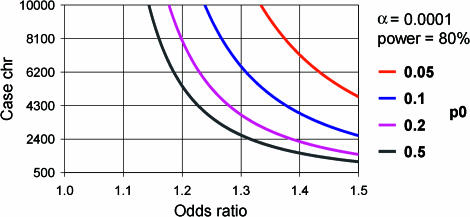
Size of Case-Control Study Required to Detect Small Risk EffectsThe number is shown of the case chromosomes (assuming an equal number of control chromosomes) required to attain 80% power to detect associations with the OR varying between 1.0 and 1.5 and with a Type 1 error rate of 0.01%. Abbreviations: p0, frequency of the predisposing allele; chr, number of chromosomes. Graphs were plotted with the PS power and sample-size program (DuPont and Plummer 1997).